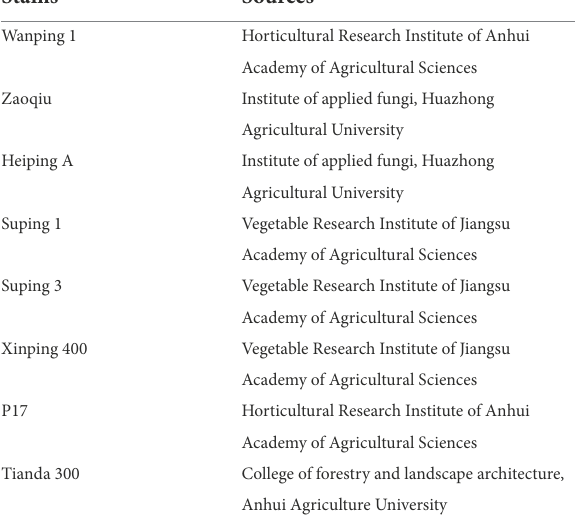
TABLE 1 Eight P. ostreatus strains used in this